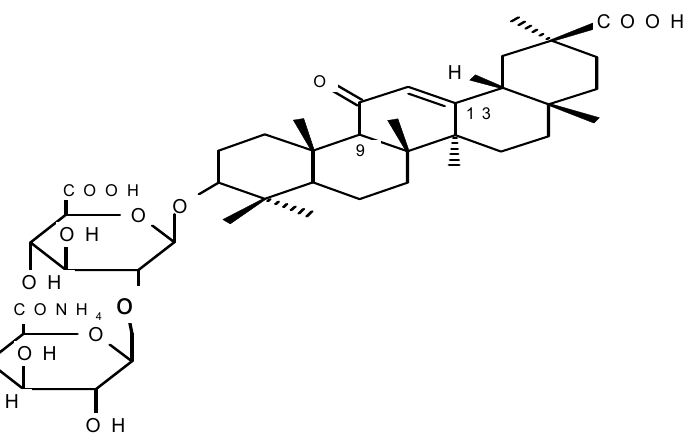
Figure 1. Structure of monoammonium salt of glycyrrhizic acid (MSGA): the right upper part is hydrophobic (triterpene part), and the left is hydrophilic (carbohydrate part).